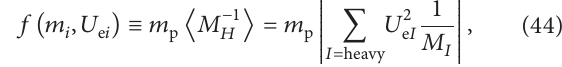
In the former case ( 𝑚 ≲ 100 MeV, see (19)), the factor 𝑓 is proportional to 𝑚 𝛽𝛽